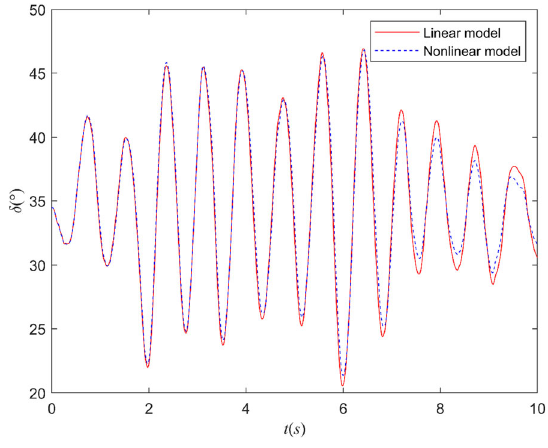
Fig. 8 Comparison of power angle curves between linear and nonlinear models of the system ( σ =